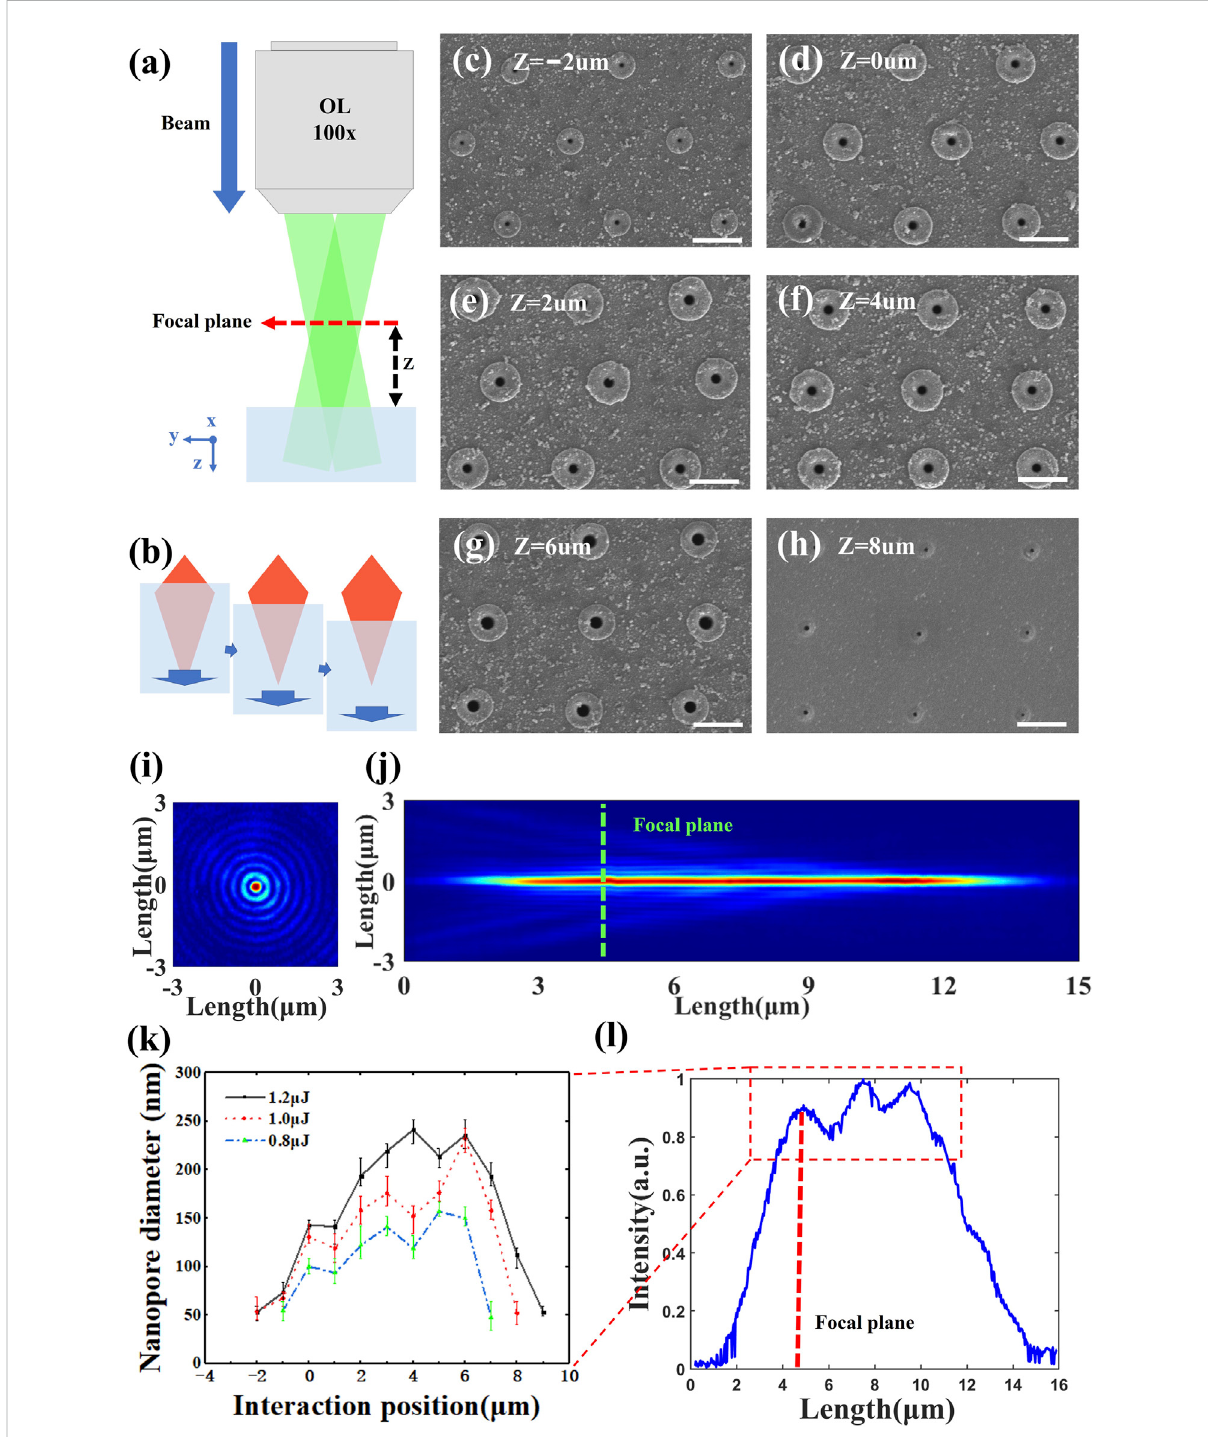
FIGURE 2 Traversing the region of femtosecond Bessel beam-silica interaction and summarizing the trend of nanopore opening size change due to the interaction region change. (A) Schematic diagram of micromachining system. (B) Schematic diagram of the variation of the Bessel beam-silica interaction region by the movement of the piezoelectric translation stage. (C – H) SEM image of a uniform nanopore array (scale bar 1 μ m) with the opening size range corresponding to different interaction regions varying from 50 to 230 nm at a single pulse energy of 1.0 μ J. (I) The Bessel beam ’ sIntensity distribution in thecross-section atfocal plane. (J) The Besselbeam ’ senergy distribution along thepropagationdirection. (K) Plot of thenanoporesurfaceopeningsizewiththevariation oftheinteractionregionofBesselbeamwithsilicaatsingle pulse energy0.8,1.0,and1.2 μ J. (L) Energy distribution pro fi le of Bessel beam at processing along the propagation